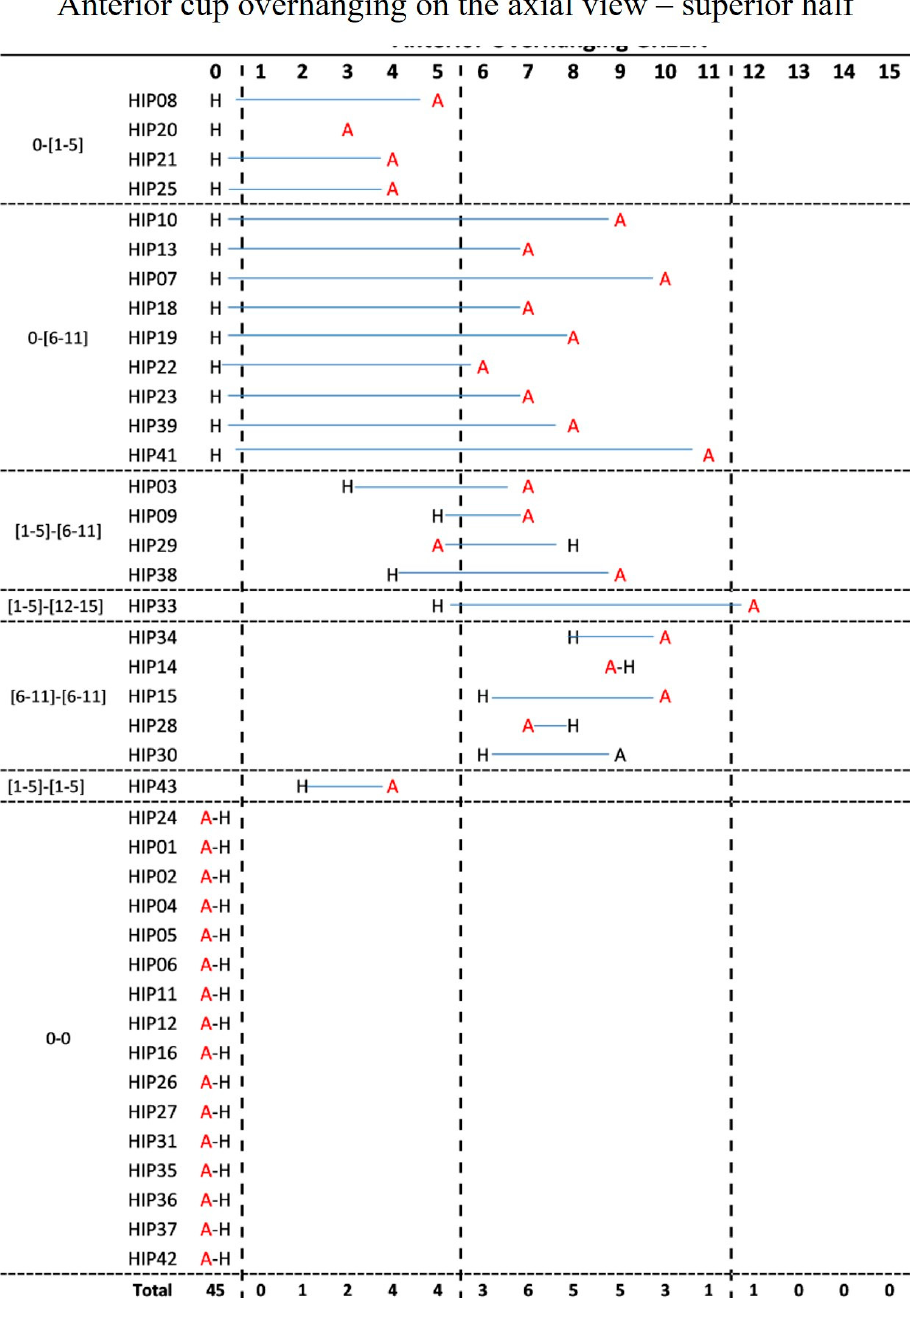
Figure 3. Anterior cup overhanging on the axial view in the middle of the superior half of the cup in the same case according to the two configurations AHCR (A) and HHCR (H). Anterior cup overhanging on the axial view at the center of the cup was not detected in 17 (42.5%) AHCR and 31 (77.5%) HHCR sockets. Prominence between 6 and 11 mm occurred in nine (22.5%) AHCR cups and one (2.5%) HHCR sockets. There was a minimal agreement between the two configurations (k = 0.23, p = 0.01) and a significant difference between the two configurations ( p < 0.001) [Figure